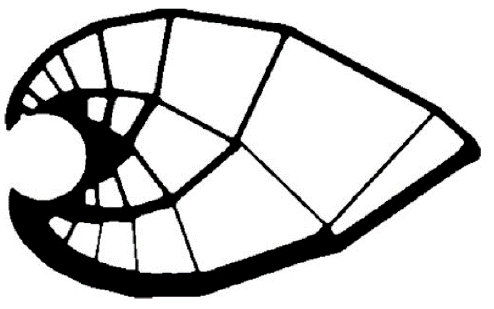
Figure 4. Gradual enlargement of the mash structure and simultaneous reduction in the member cross-section [9].